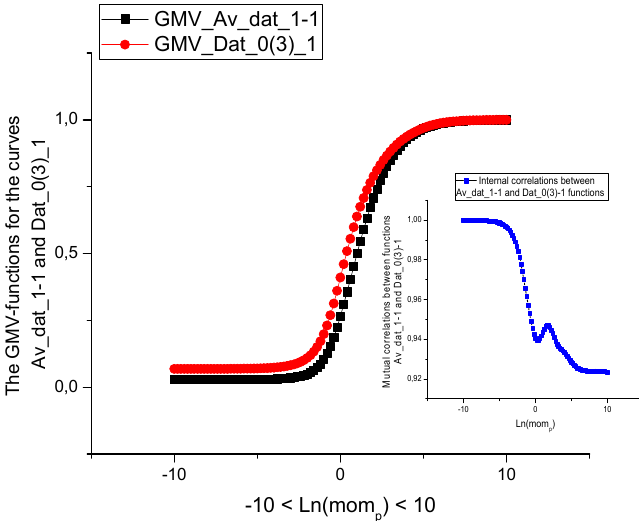
Figure 3. In the central figure we compare the GMV-functions for the same curves Av_dat_1-1 and Dat_0 (3) calculated in the space of the fractional moments. In the right corner below we depict the generalized Pearson correlation function (Equation (2)) in the space of the fractional moments placed in the same interval [ − 10, 10].